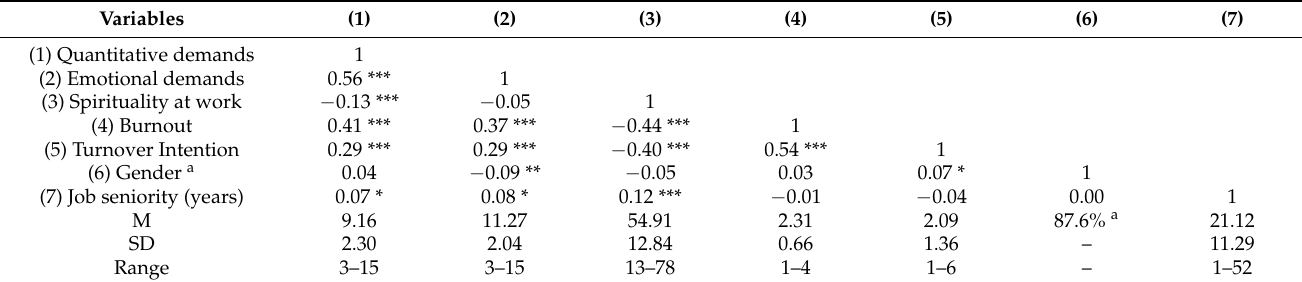
Table 2. Means, standard deviations, and zero-order correlations between the study variables.